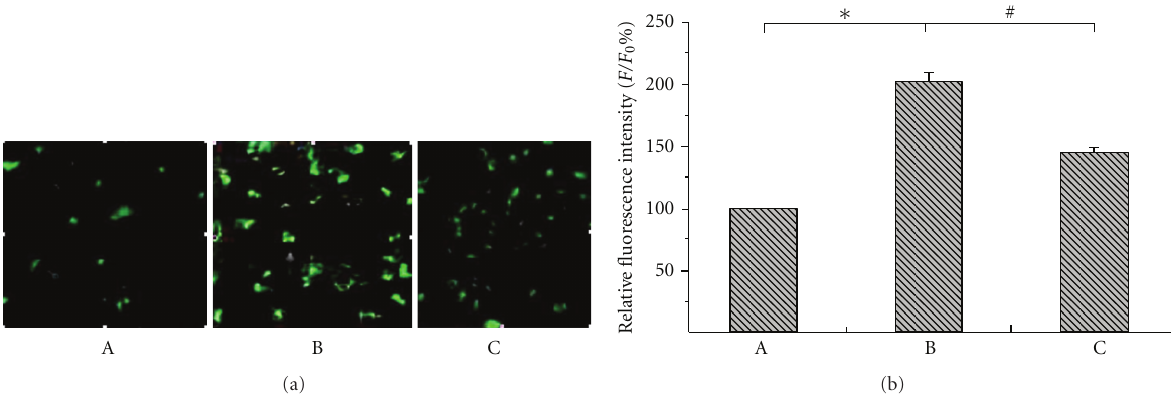
Figure 4: (a) Fluorescence images of [Ca 2+ ] i changes as measured using a confocal microscope. A: control group; B: injury group; C: Verapamil-treated group. (b) The values represented the average relative fluorescence intensity ( ∗ P < 0 . 01, # P < 0 . 05). A: control group; B: injury group; C: Verapamil-treated